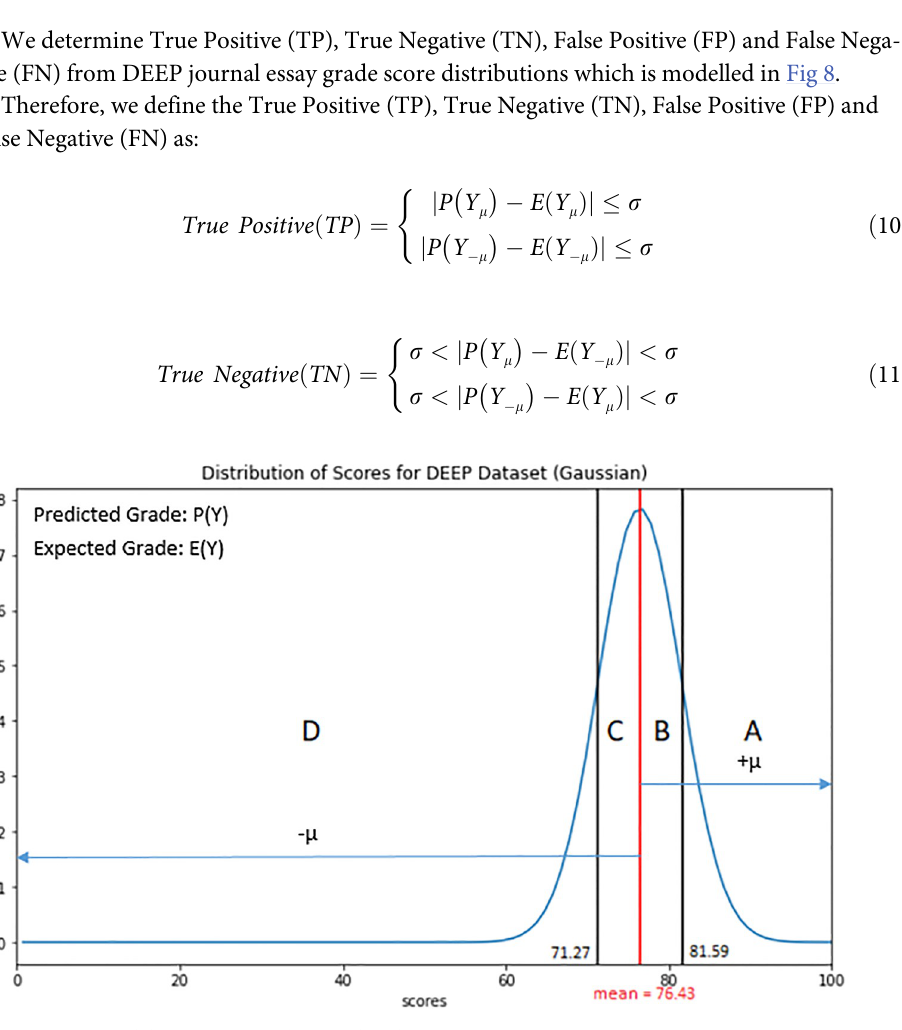
Fig 8. DEEP journal dataset essay grade score